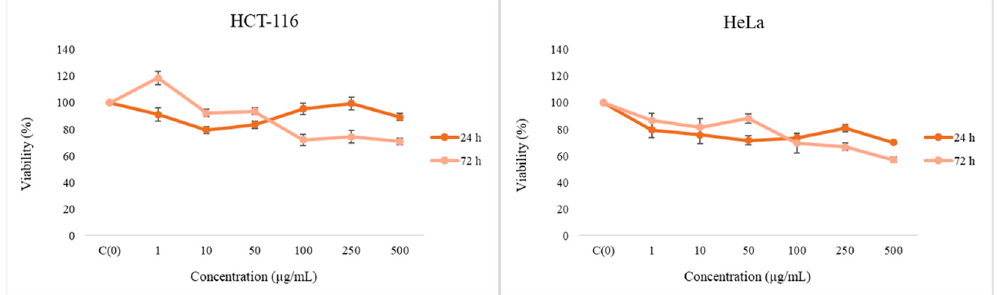
Figure 1. Effects of LSEA on HCT ‐ 116 and HeLa cell line viability 24 and 72 h after treatment.